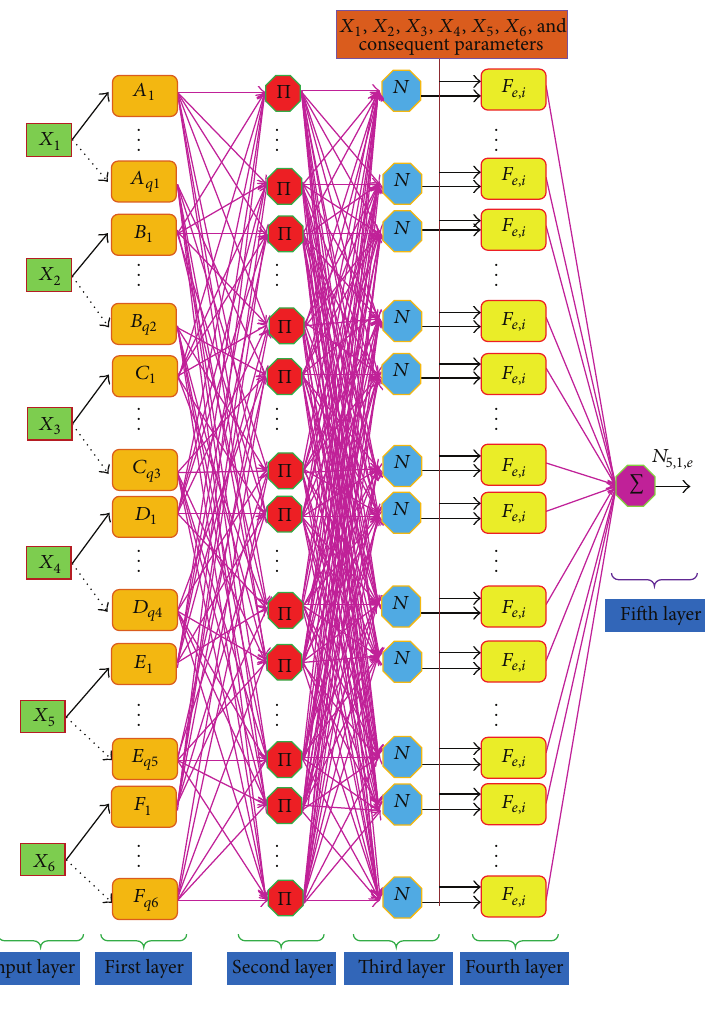
Figure 7: Adaptive neurofuzzy inference system (ANFIS) for crack